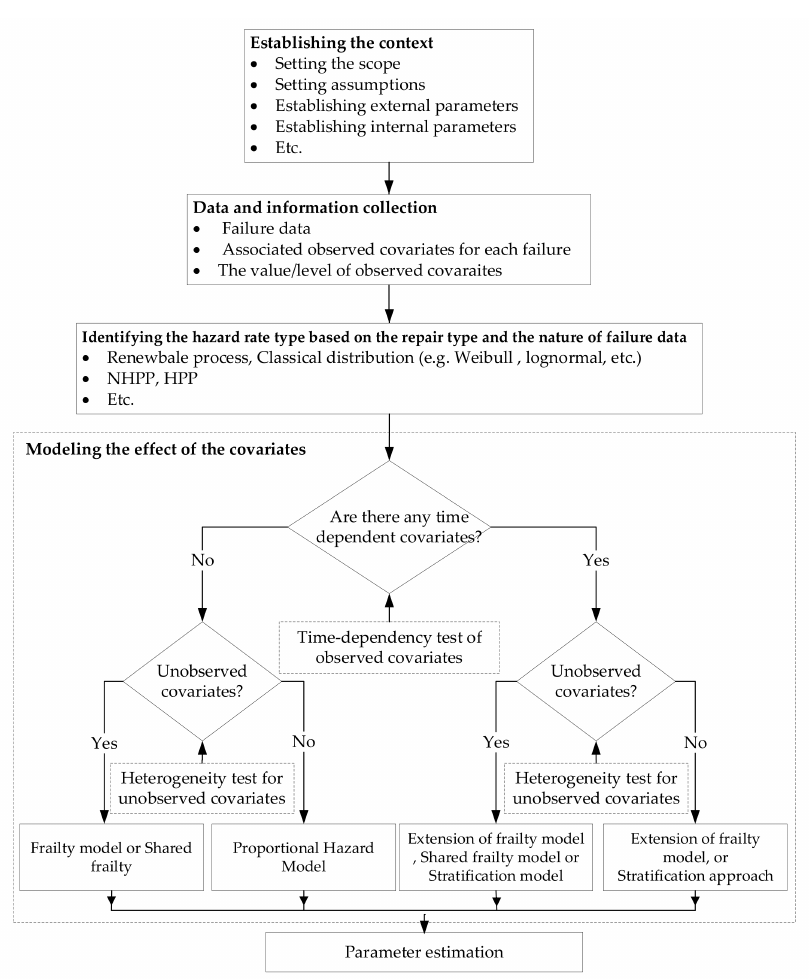
Figure 3. A framework for the reliability model